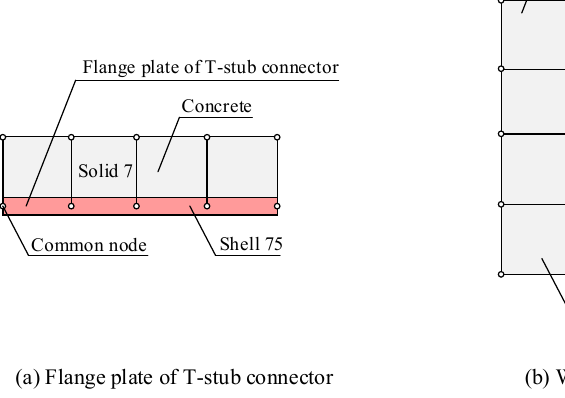
Figure 8. Modelling of interfaces between steel plates and concrete.